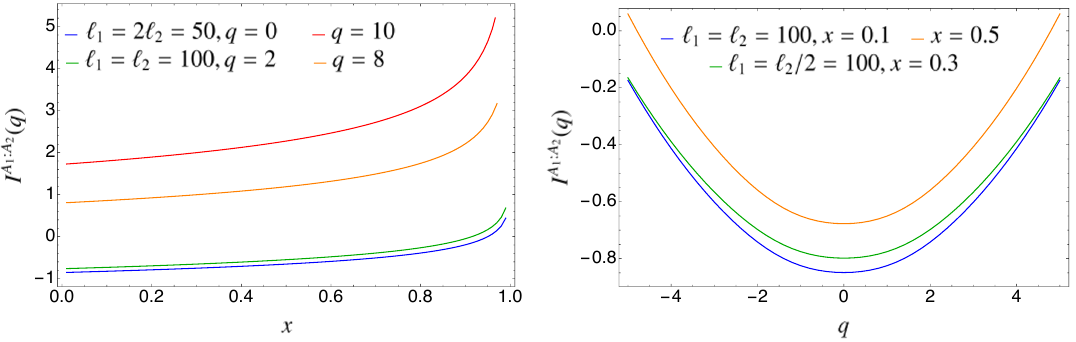
Figure 5 . Symmetry-resolved mutual information of eq. (5.14) in the tight-binding model. We plot our analytical prediction for different combinations of ‘ 1 , ‘ 2 as a function of the cross-ratio x (left panel) and q (right